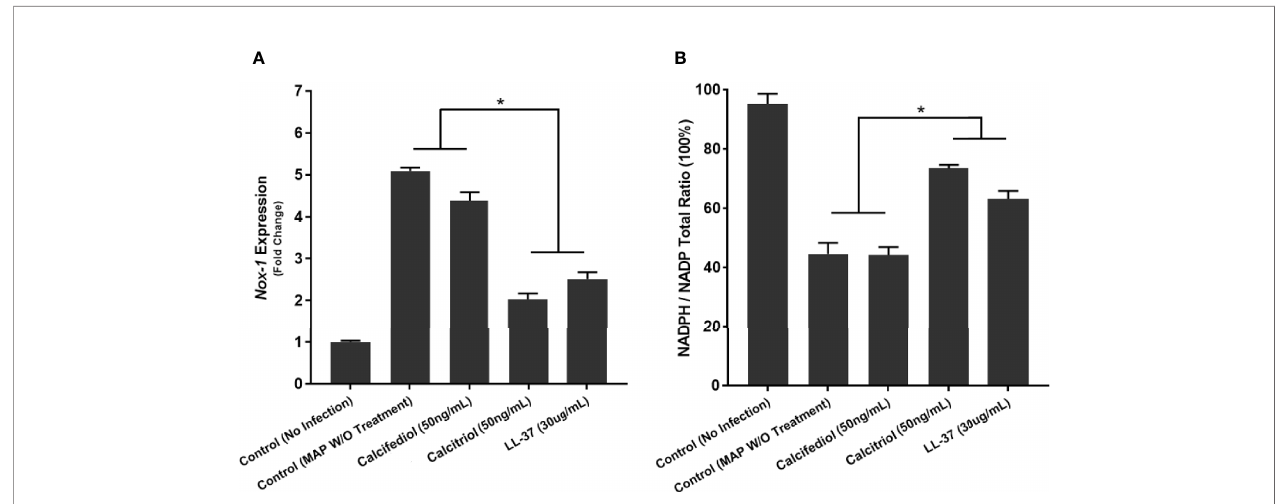
FIGURE 11 | Quantitative Analysis of Oxidative Stress levels inCaco-2 CellsCo-Cultured with MAP-infected Macrophages following24 hours ofcalcitriol or LL-37 treatment. Expression of NOX-1 was quanti fi ed as foldchange incomparisonto Caco-2 cellsco-cultured with uninfected macrophages (A) . Ratio of NADPH to NADP in lysate ofCaco-2 cellsexpressedas a percentage (B) was measured using the NADP/NADPH Assay Kit (Abcam,Cambridge, UK). *Indicates P-value of less than